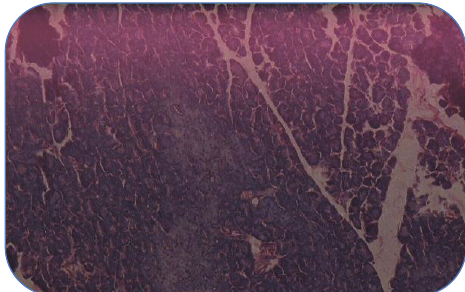
Figure 2: Pancreatic section of STZ-intoxicated rat stained with haemotoxylin and eosin.